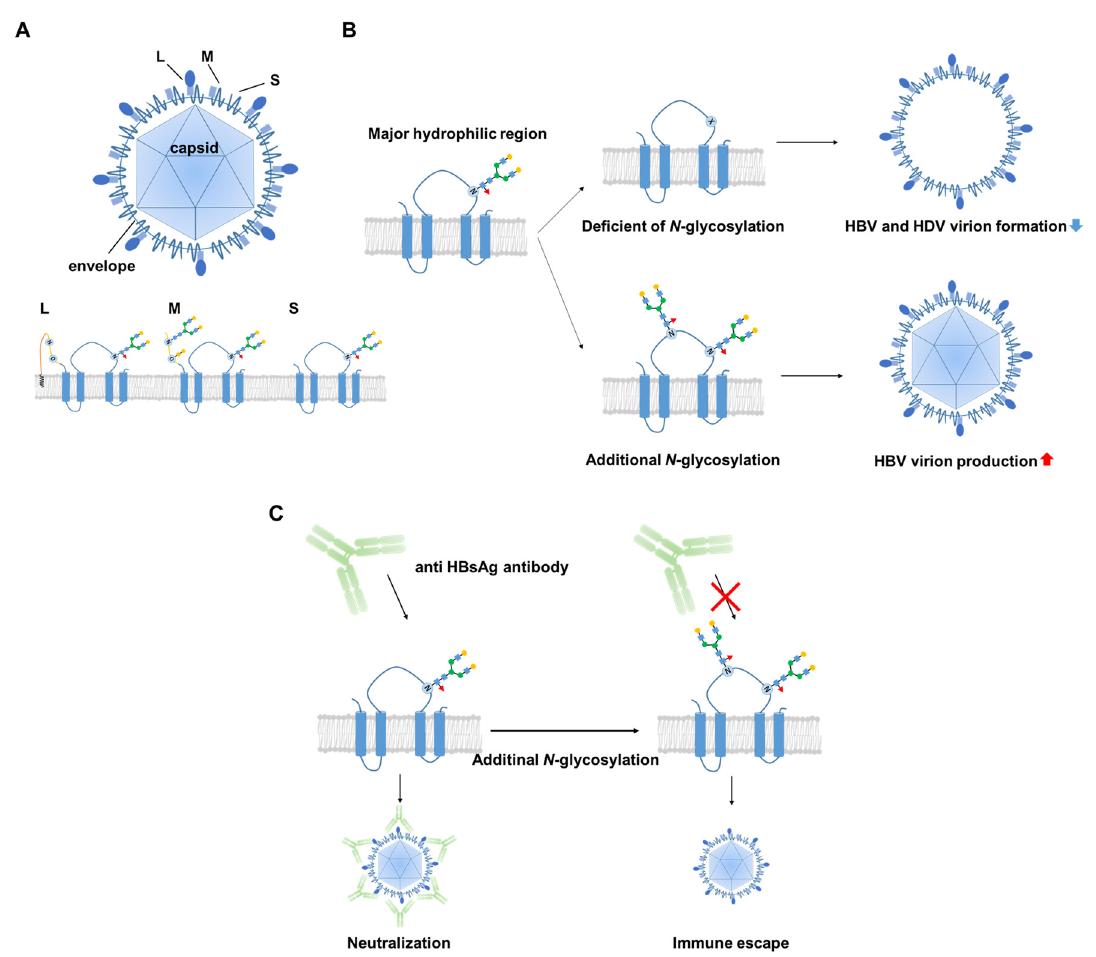
Figure 1. Relationship between HBV and glycosylation. ( A ) Structure of HBV. HBV consists of a nucleocapsid protected by a lipid membrane with small (S), medium (M), and large (L) surface proteins. A potential N -glycosylation site is located at Asn-146 of the S domain (blue). M protein has another N -glycosylation site at Asn-4 and O-glycosylation site at Thr-37 in the preS2 region (yellow). However, this glycosylation disappears in L proteins. ( B ) The HBV envelope proteins are glycosylated at position N146 in the S domain. Deficiency of N -glycosylation on HBV envelope proteins is tolerated for the assembly of subviral HBV particles and the in vitro infectivity of HDV, but is partially inhibitory for the formation of HBV and HDV virions. Additional N -glycosylation increases HBV virion production. ( C ) Additional N -glycosylation contributes mostly to immune escape and resistance to neutralizing antibody.